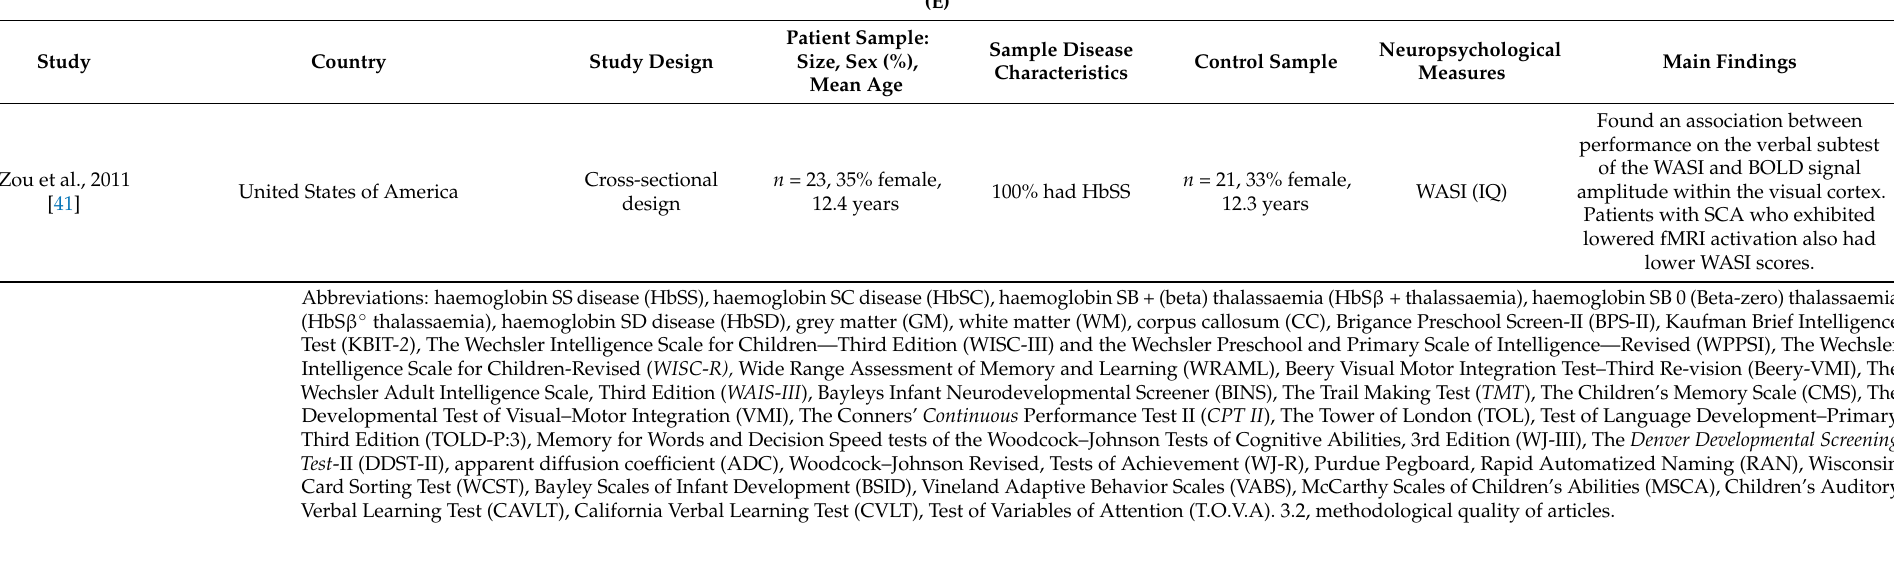
Table 3. Cont. United States of America